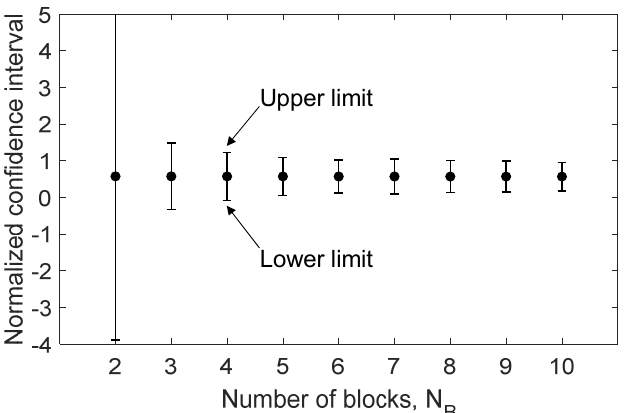
Figure 14. Confidence interval of the damage for the measured time history z ( t ) from the vehicle wheel (CH4 record, inner rim), as a function of number of blocks, N B